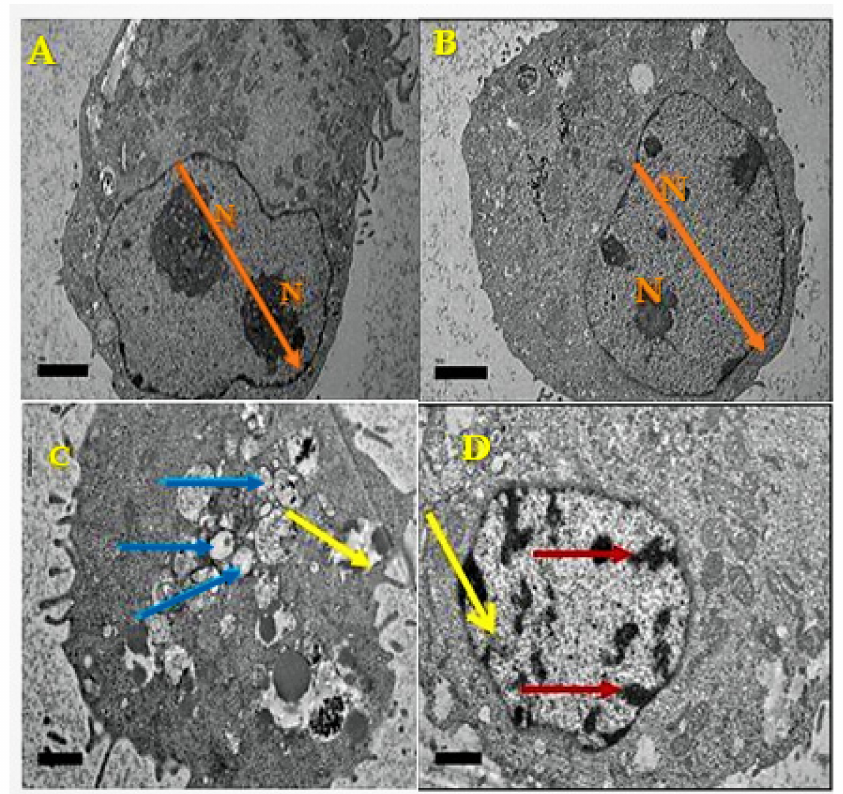
Figure 2. Transmission electron microscope of MCF-7 cancer cells. ( A ) Control (untreated) cells (mag- nification × 10,000) and nucleus as indicated with N. ( B ) Cells treated with Ar-CC-NPs (magnification × 10,000) and nucleus as indicated with N. ( C ) Cells treated with DOX-Ar-CC-NPs (magnification × 7000) with cell dispersion effect as indicated with blue arrow and membrane blebbing indicated by the yellow arrow. ( D ) Cells treated with DOX-Ar-CC-NPs (magnification × 5000) with chromatin condensation indicated with a yellow arrow, while red arrow indicates DOX-Ar-CC-NPs in the endosome vesicles. Bar 2 µ